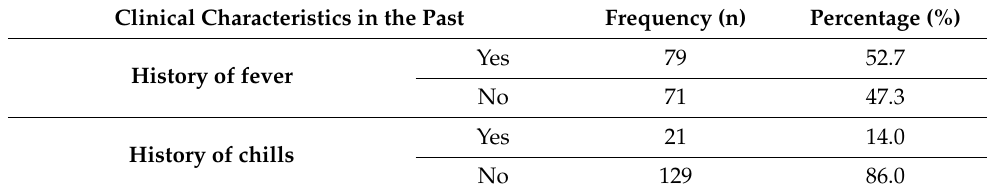
Table 2. Clinical characteristics of HIV